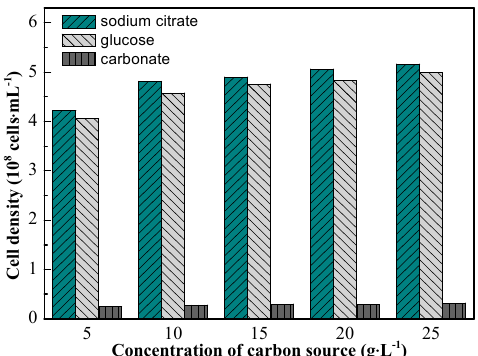
Figure 3. Effect of different kinds of carbon source and different concentrations of carbon source on strain growth. The cell densities were measured at the stationary phase of strain.